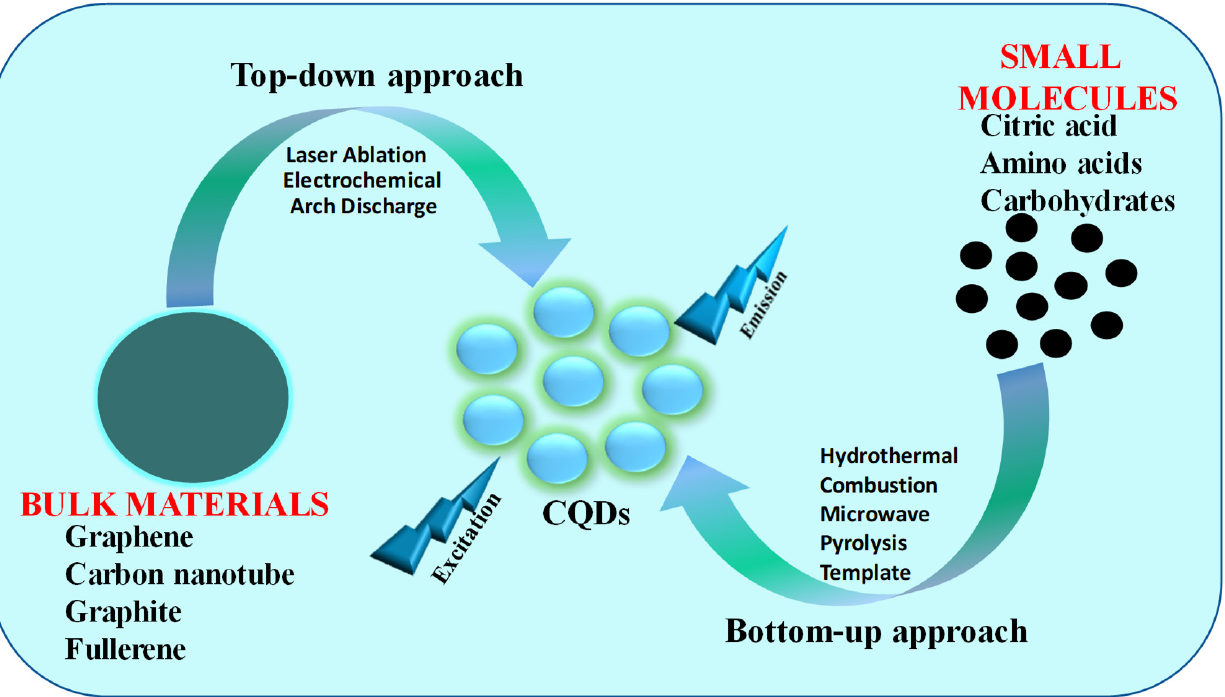
Figure 1. The typical approaches for the synthesis of CQDs.